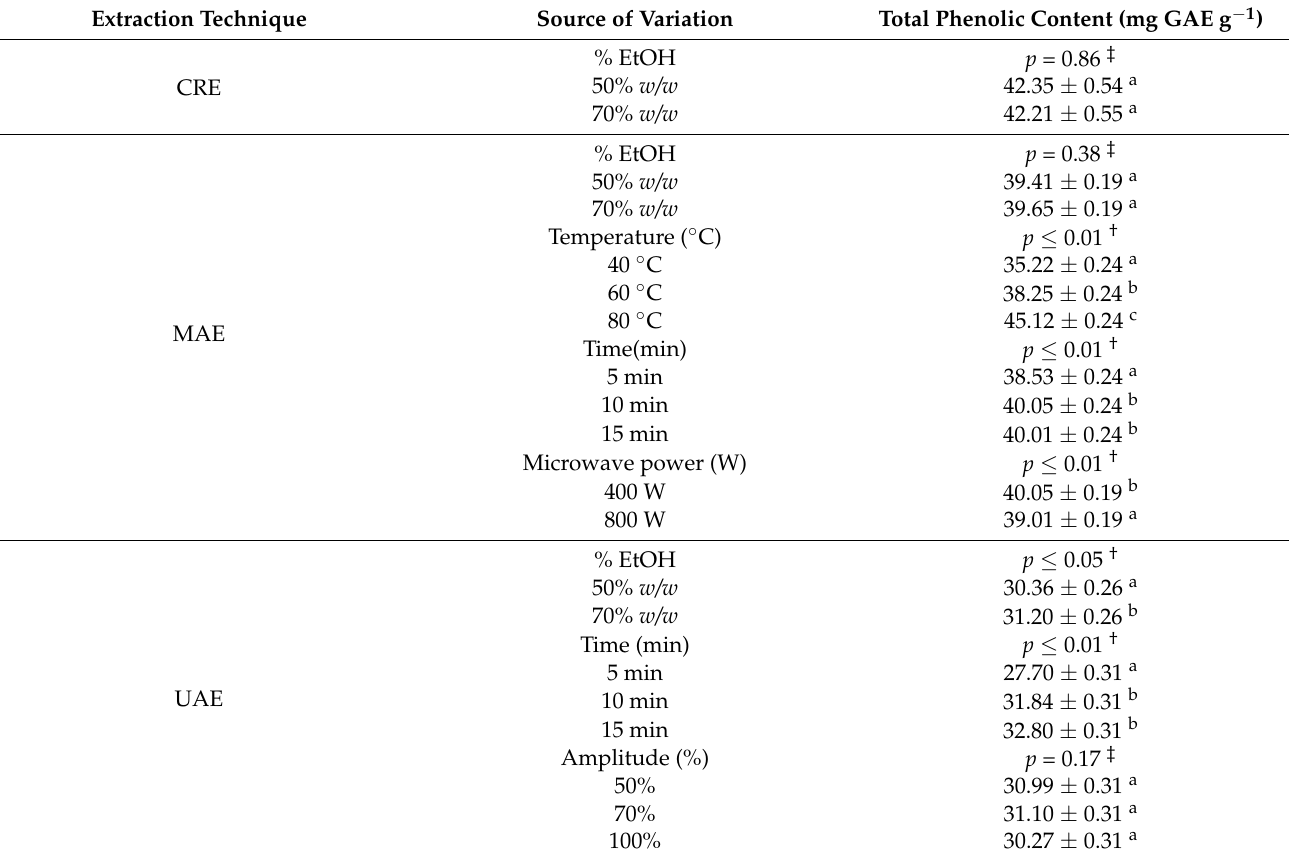
Table 2. Influence of extraction parameters on total phenolic content of L. nobilis leaf extracts. Extraction